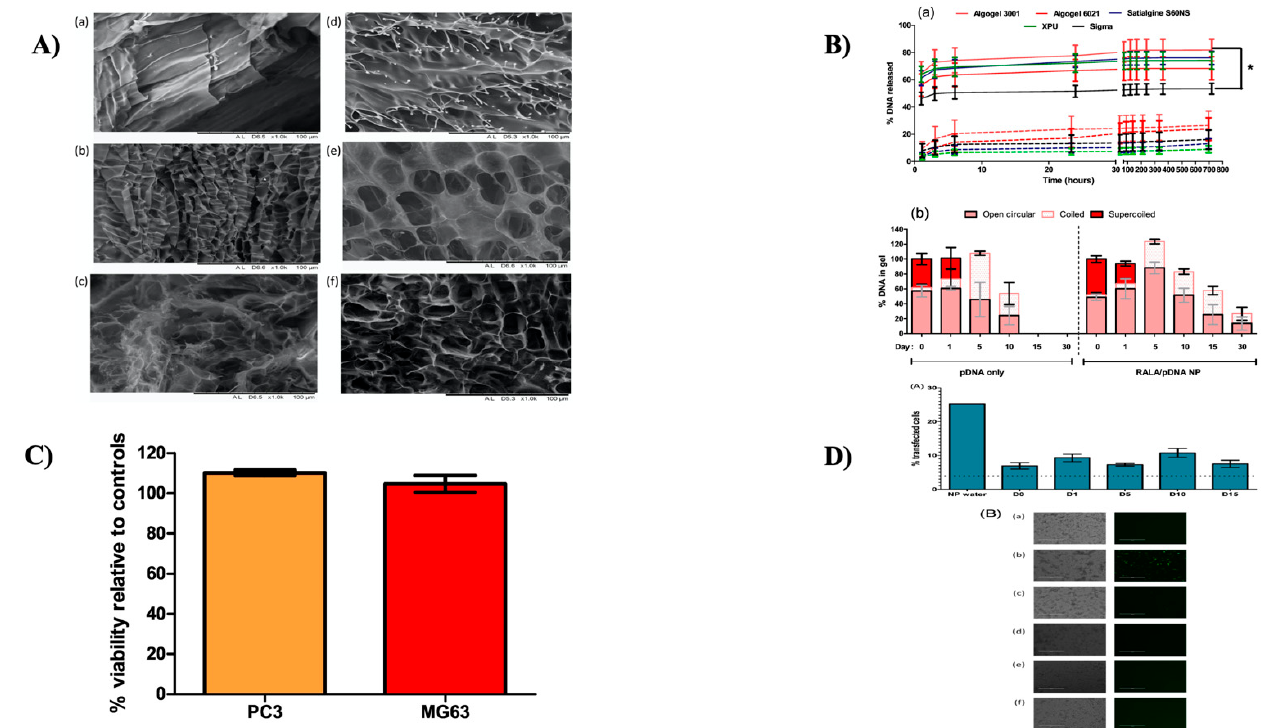
Figure 3. ( A ) SEM structural analysis of Alg-g-P (NIPAAm) hydrogels premised on (a) Algogel3001, (b) Algogel6021, (c) Satialgine S60NS, (d) SatialgineS900NS, (e) Sigma, and (f) XPU alginate. ( B ) As a pDNA and RALA/pDNA NPs delivery device, Alg-g-PNIPAM hydrogel was used. (a) For up to one month in DDW at 37 °C, hydrogels discharged pDNA (continuous line) at a faster rate (burst release) than RALA/pDNA NPs (dashed line). (b) DNA stability was sustained in algogel 3001-g-P (NIPAAm) hydrogels for uncomplexed pDNA for up to 10 days and complexed RALA NPs for up to 30 days; * p < 0.05. ( C ) Degradation of algogel 3001-g-PNIPAM hydrogel at 70 °C in cell medium for 3 days caused cytotoxicity in PC3 and MG63 cells. ( D ) Evaluation of DNA transfection effectiveness after 15 days of incubation in Alg-g-PNIPAM hydrogel (A) flow cytometry analysis for transfection efficiency (B) The prevalence of green fluorescent protein-expressing cells for the various treatment groups. Reproduced with permission from [212], copyright Elsevier, 2017.